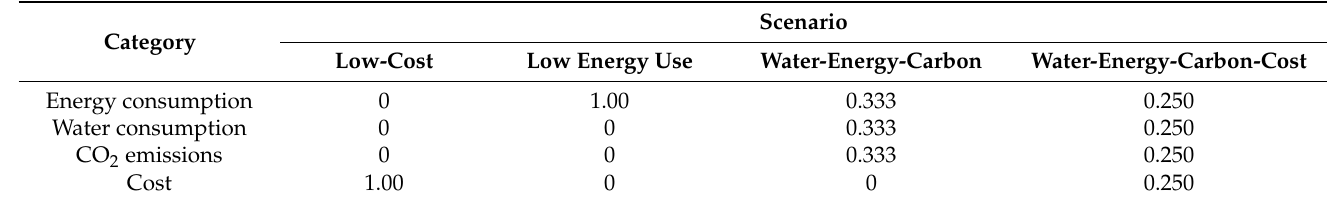
Table 2. Weighting coefficients in each